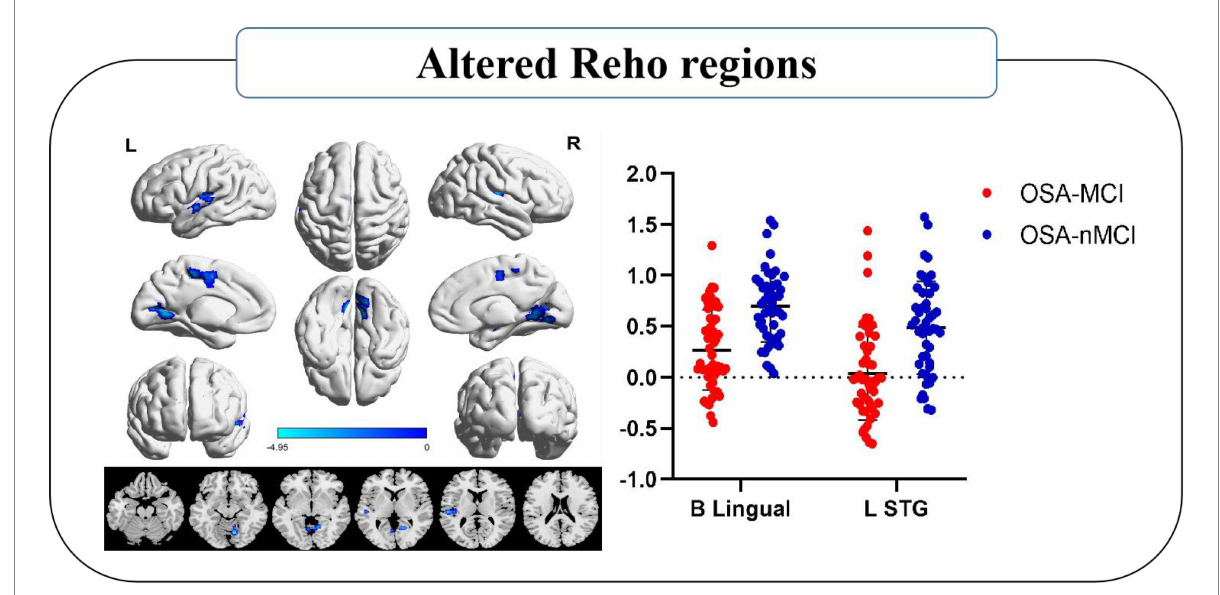
FIGURE 2 Significantly different Reho was observed between the OSA-MCI and OSA-nMCI groups. Reho values decreased significantly in the MCI group compared to the nMCI group (blue). B, bilateral; L, left; STG, superior temporal